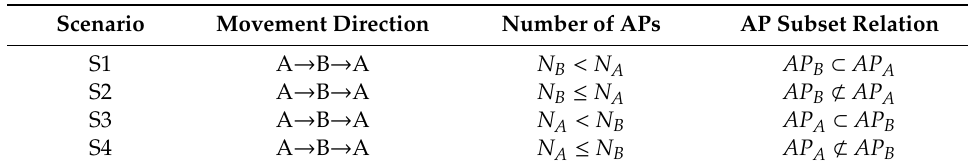
Table 1. Dynamic scenarios of localization.